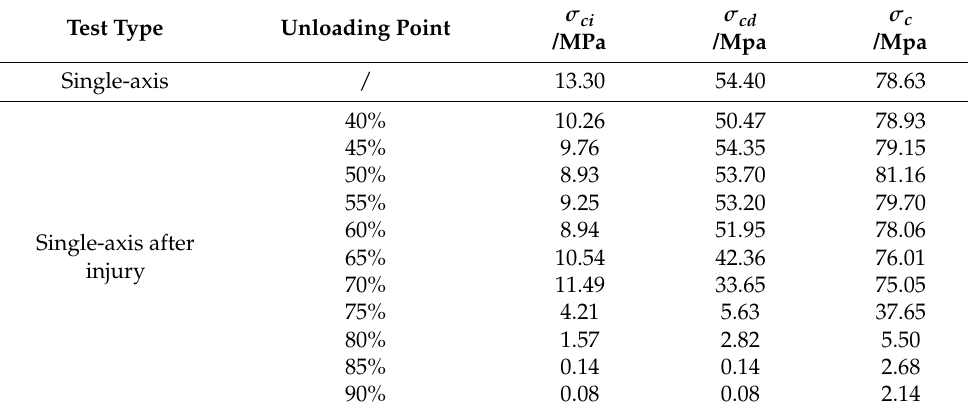
Table 1. Characteristic strengths of sandstone under uniaxial reloading with different peak front unloading point